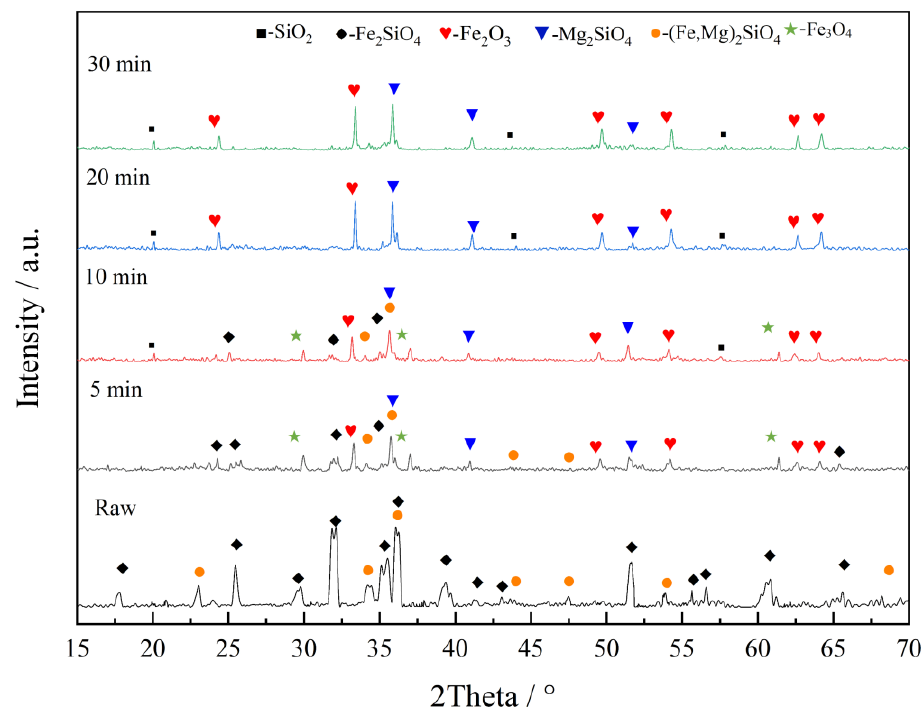
Figure 7. XRD patterns of nickel slag samples after oxidation at 900 °C in different intervals.